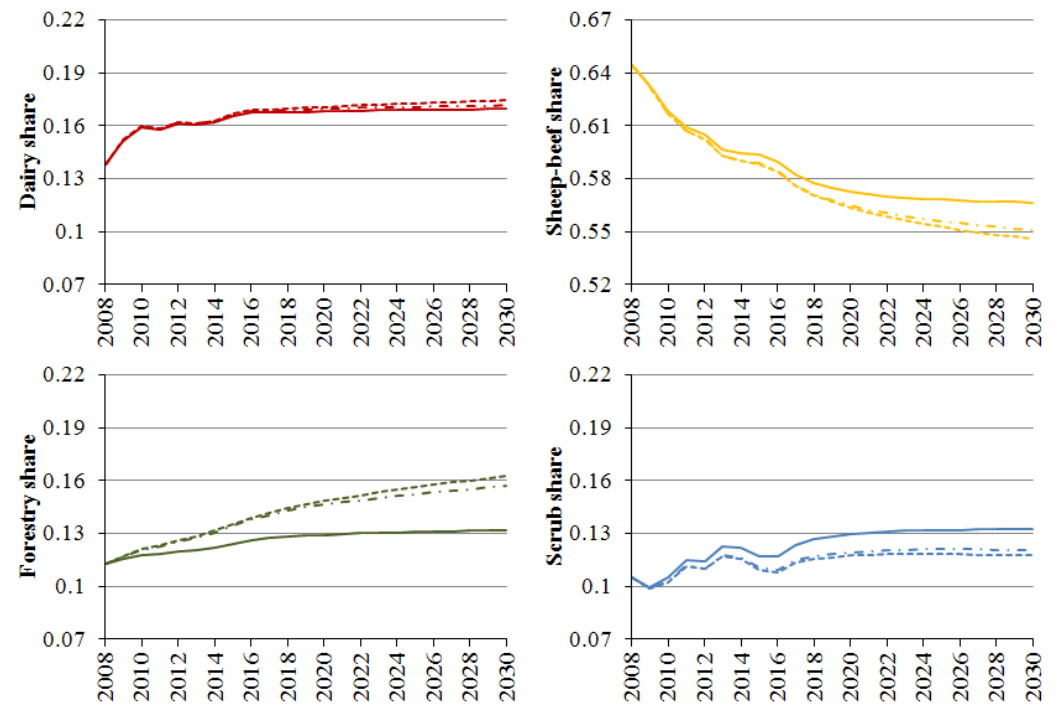
Figure 2. National land-use share projections by policy scenario, 2009–2030. Solid lines give baseline projections. Dash-dot lines give an ETS without agriculture. Dashed lines give the full ETS. Note that the y -axis does not extend to zero; however, the vertical spread of each y-axis is the same so that comparisons can be made across